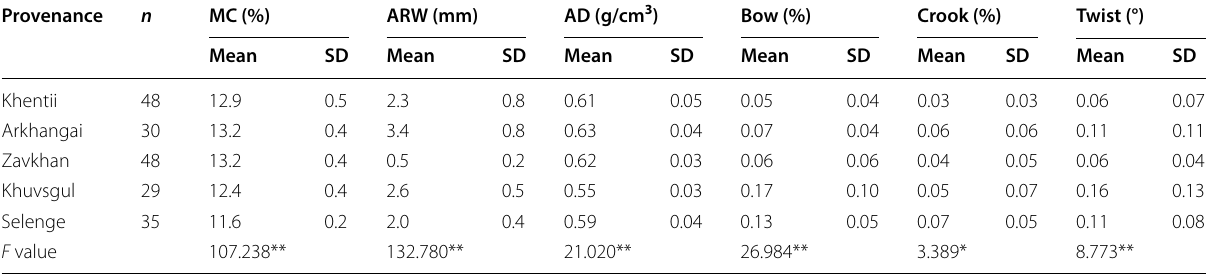
n : number of lumber; MC: moisture content determined by oven-dry method; ARW: annual ring width; AD: air-dry density; SD: standard deviation